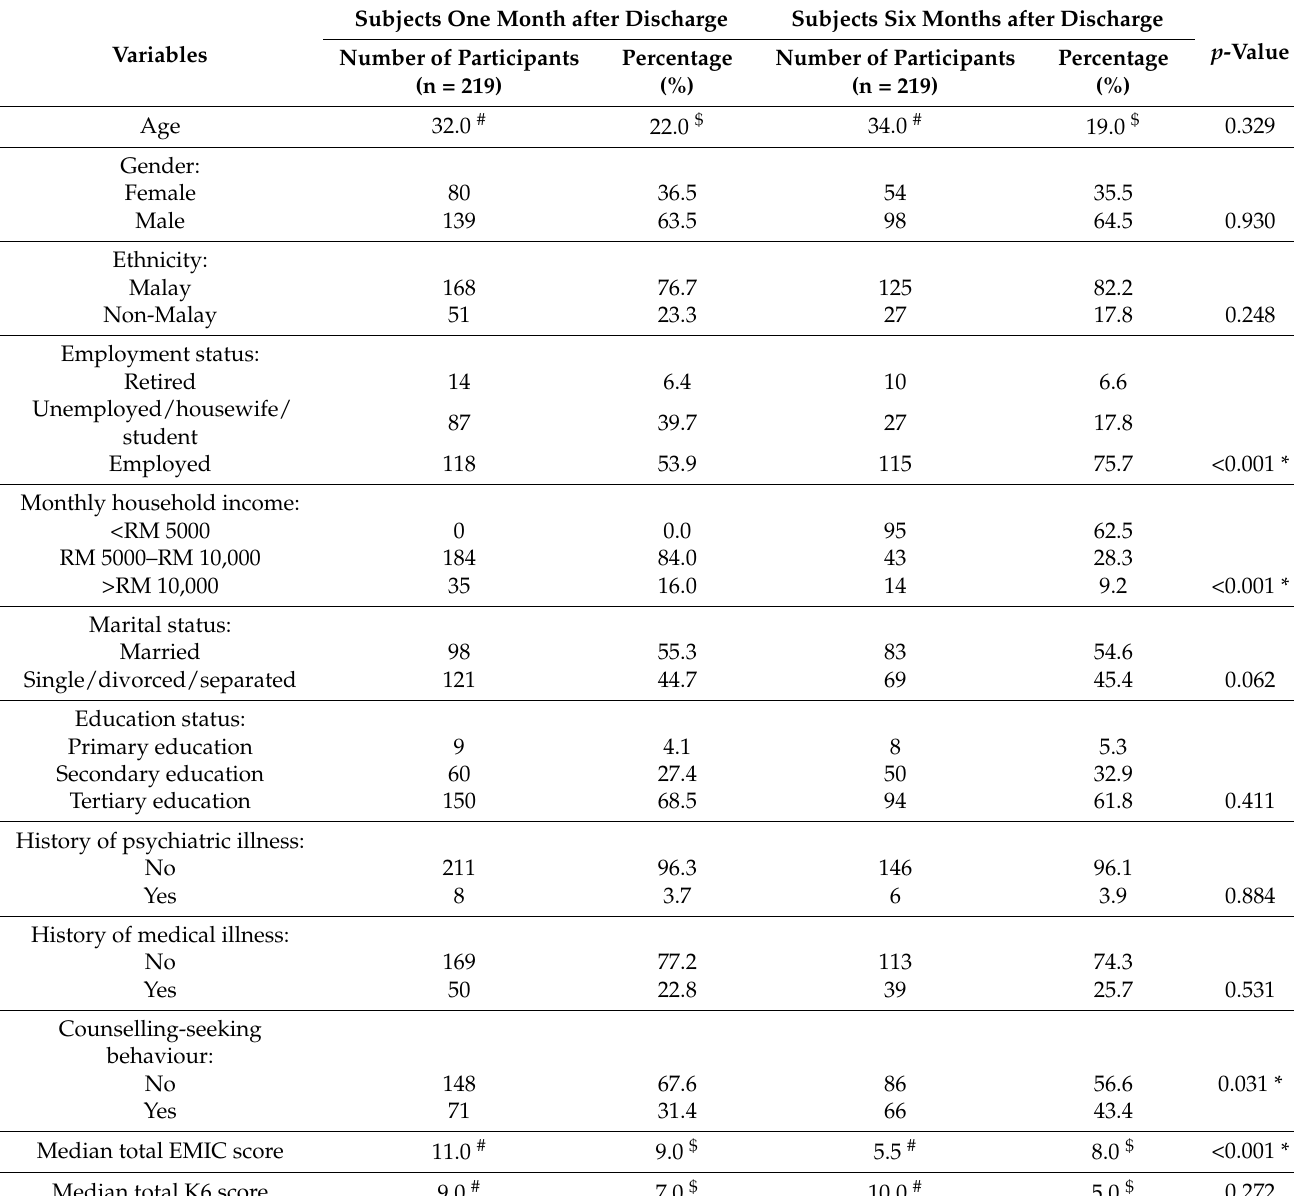
Table 1. Sociodemographic and clinical characteristics of